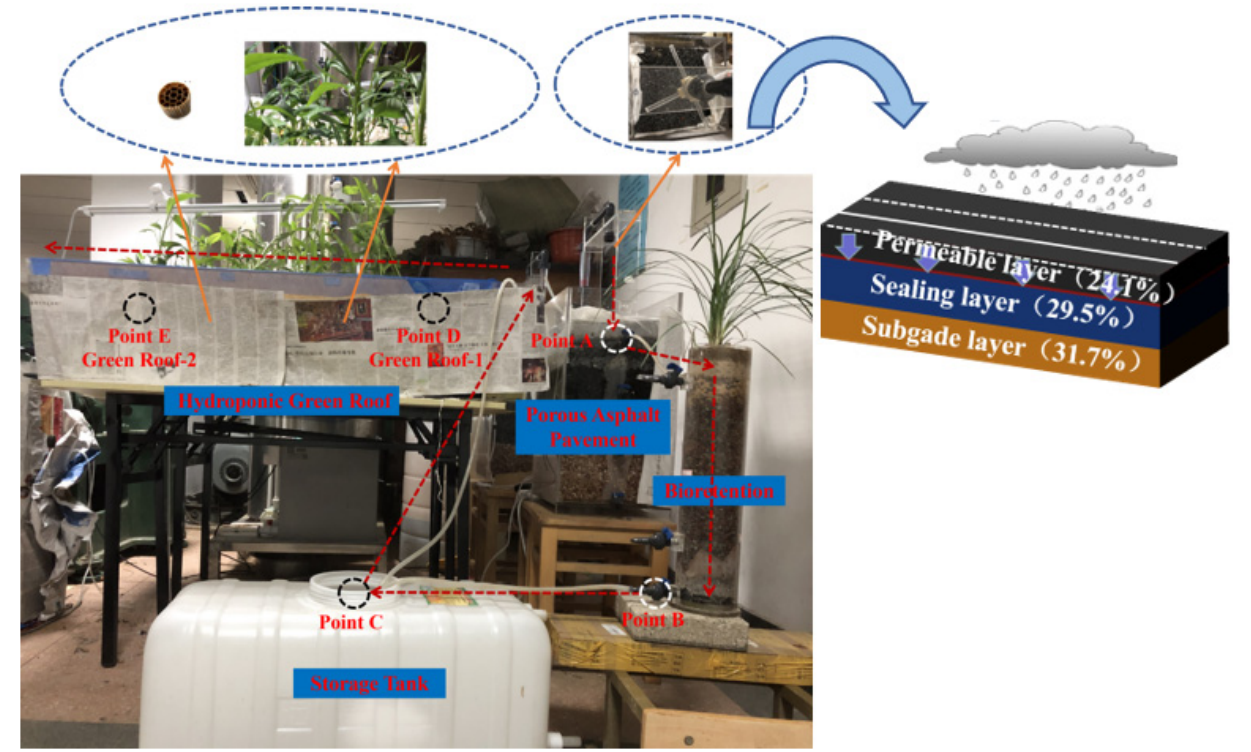
Figure 1. Photogram of the multi-level ecological system used for the treatment of road rainfall–runoff.